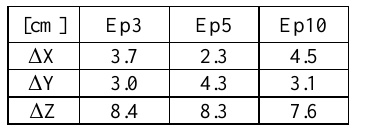
Table 7. The RMSE for 37 even distributed images for RIBC.